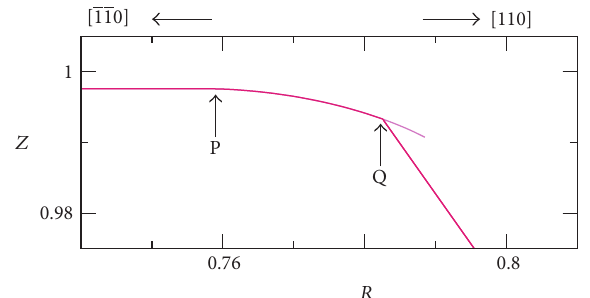
Figure 4: Profile of the Andreev free energy, which is also the profile of the ECS. 𝑘 𝐵 𝑇/𝜖 = 0.63 , 𝜖 int /𝜖 = −0.9 . 𝑍 = (𝜆/𝜖)𝑧(𝑥, 𝑦) , 𝑅 = ±√𝑋 2 + 𝑌 2 with 𝑋 = 𝑌 , (𝑋,𝑌) = (𝜂 −(𝜆𝑥/𝜖, 𝜆𝑦/𝜖) , where 𝑧 = 𝑧(𝑥,𝑦) represents the ECS and 𝜆 represents the Lagrange multiplier related to the crystal volume. We assume 𝜖 surf is equal to 𝜖 . The points P and Q indicate the (001) and (111) facet edges, respectively. At Q, the (111) surface and the surface with slope 𝑝 1 have the same value of Andreev free energy. The pale pink line near Q indicates a metastable surface. The end point of the pale pink line shows the spinodal point